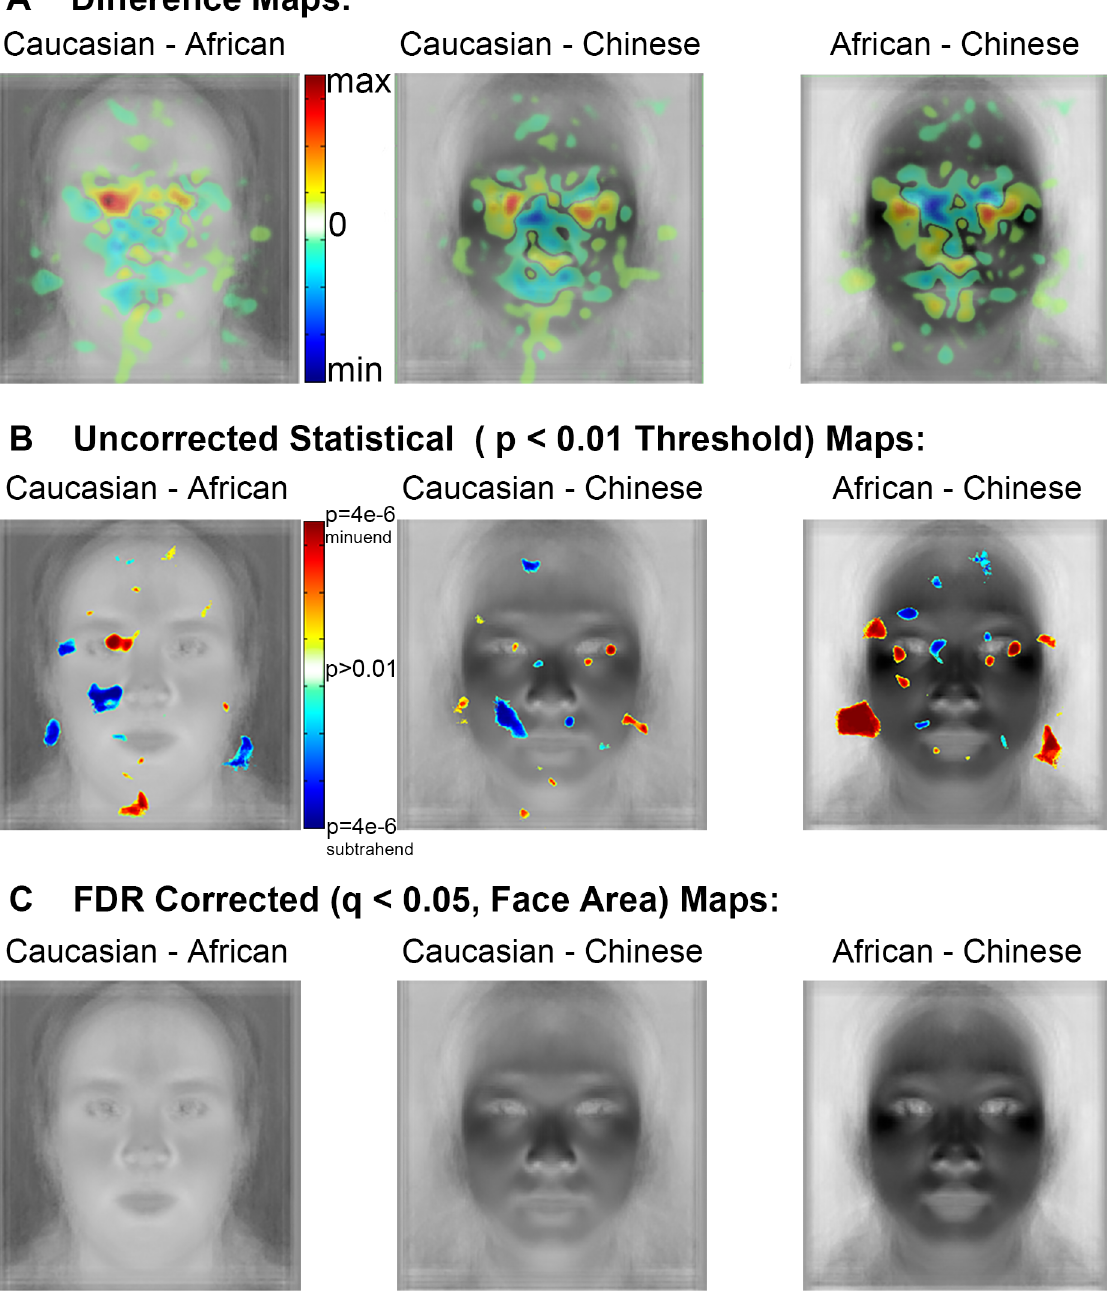
Fig 5. Spatial density contrast maps. (a) Spatial density difference maps showing numerically greater fixation density over the eyes and numerically lesser fixation density over the nose and mouth of own- than other-race faces. (b) Statistical maps thresholded at p < 0.01, uncorrected, suggesting fine differences in fixation density for the features of own- and other-races faces and also evidence of greater diffusivity of the spatial extent of fixation patterns for other- compared to own-race faces. (c) The same statistical maps from (b) FDR corrected at q < 0.05 reveal that no differences survive the